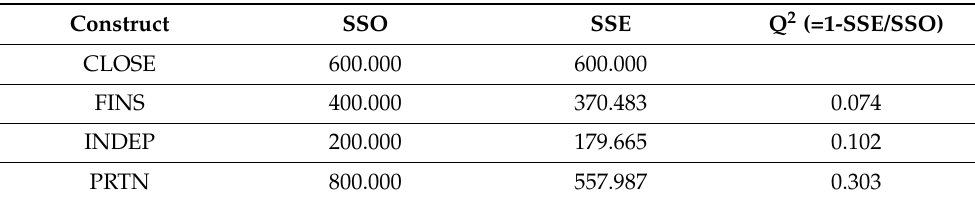
Table 8. Blindfolding test.